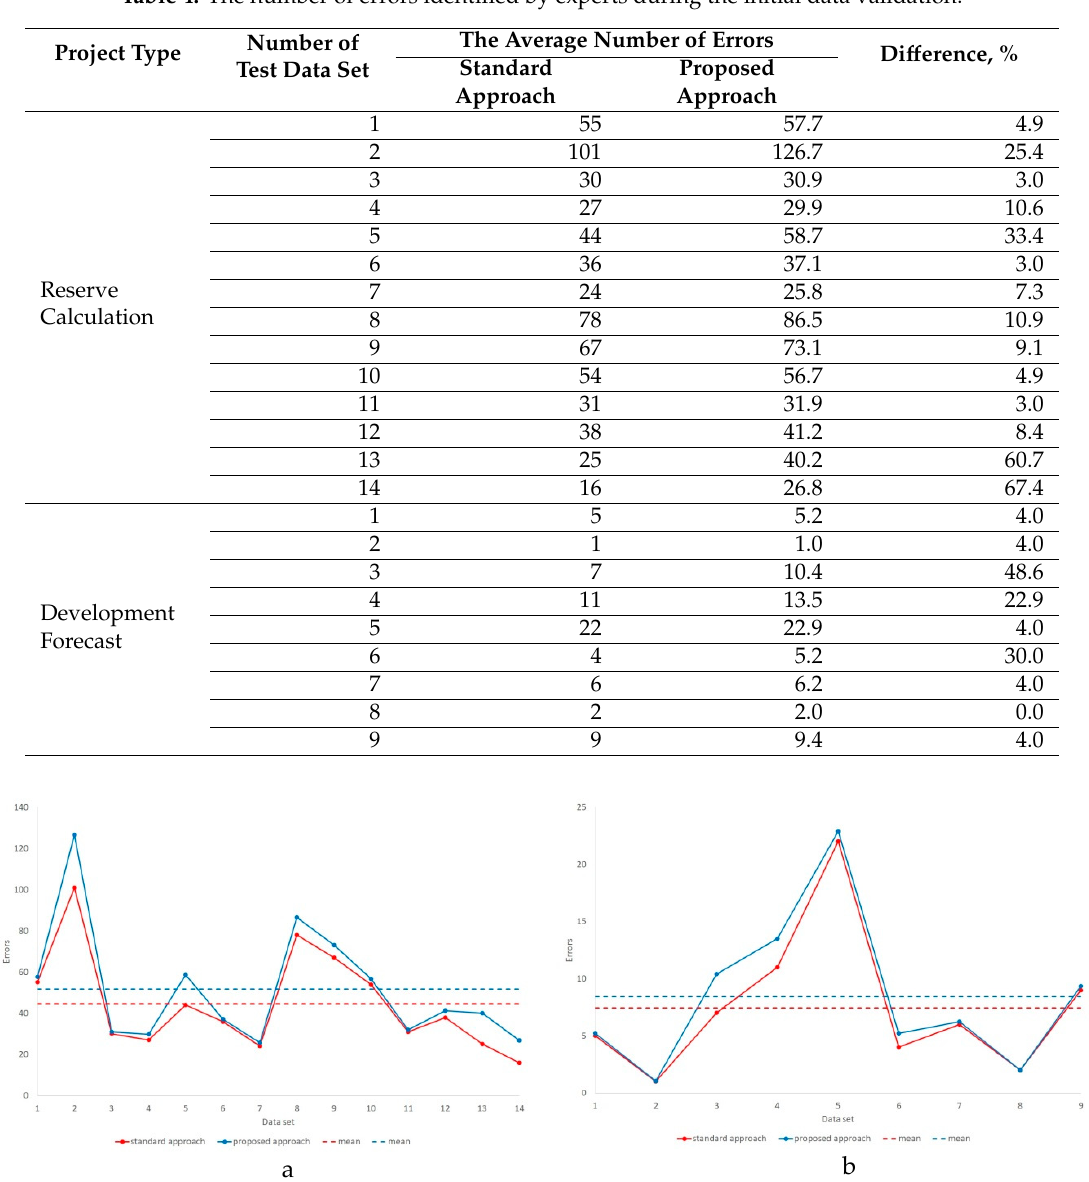
Figure 8. The number of errors identified by experts in the initial data validation in the task of: ( a ) reserve calculation; ( b ) development forecast in comparison with approved projects